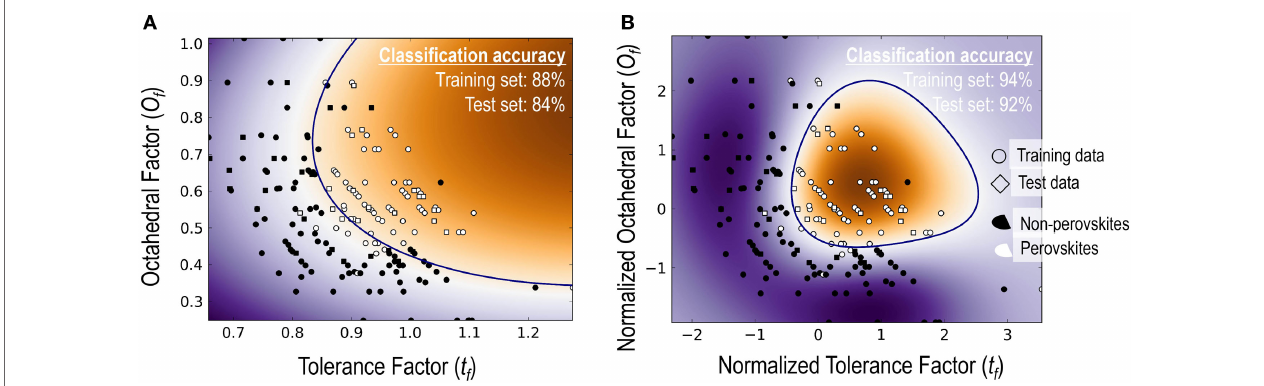
FIGURE 3 | A comparison of classification performance for the SVC models with t f – o f feature pair (A) when both features used as is and (B) when both features were normalized with a zero mean and unit variance .